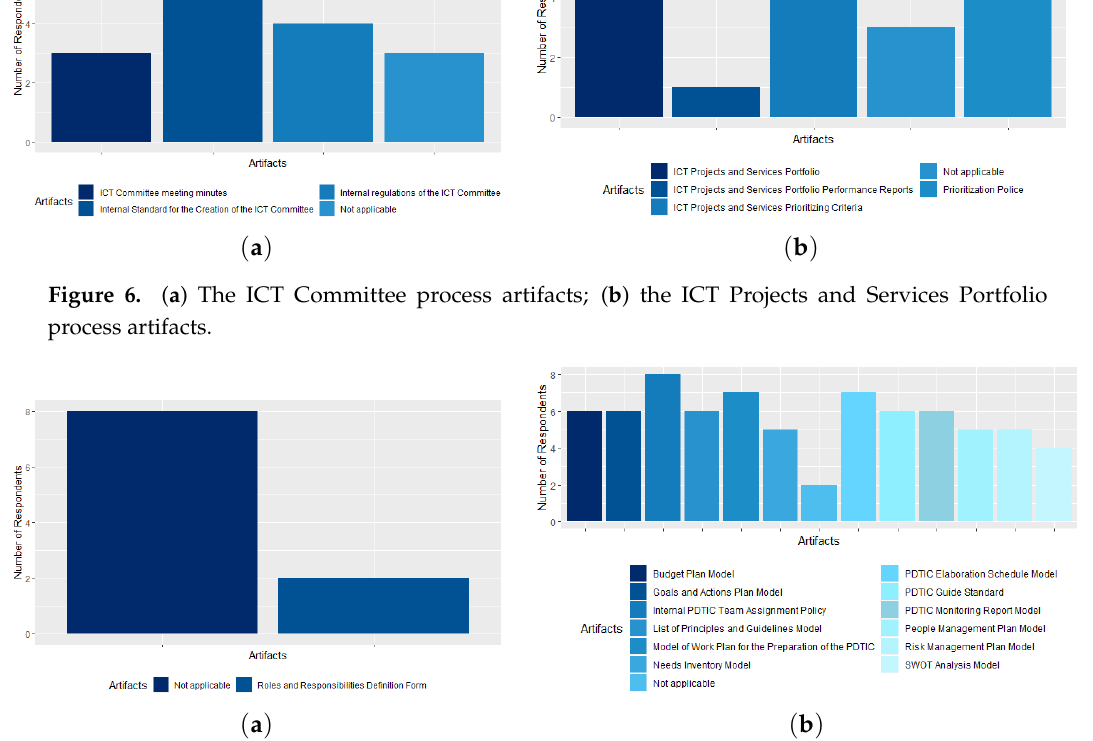
Figure 7. ( a ) The ICT People Management process artifacts; ( b ) the Information and Communication Technology Master Plan process